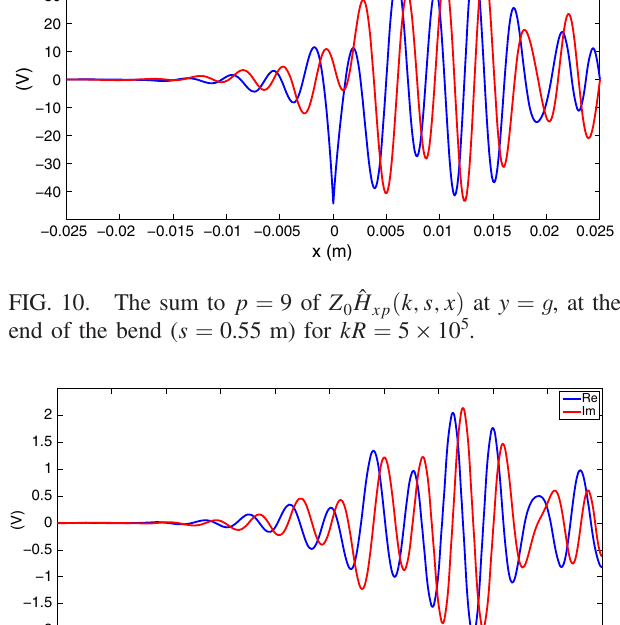
ˆ H k; s; x Þ at y ¼ g , at the sp ð